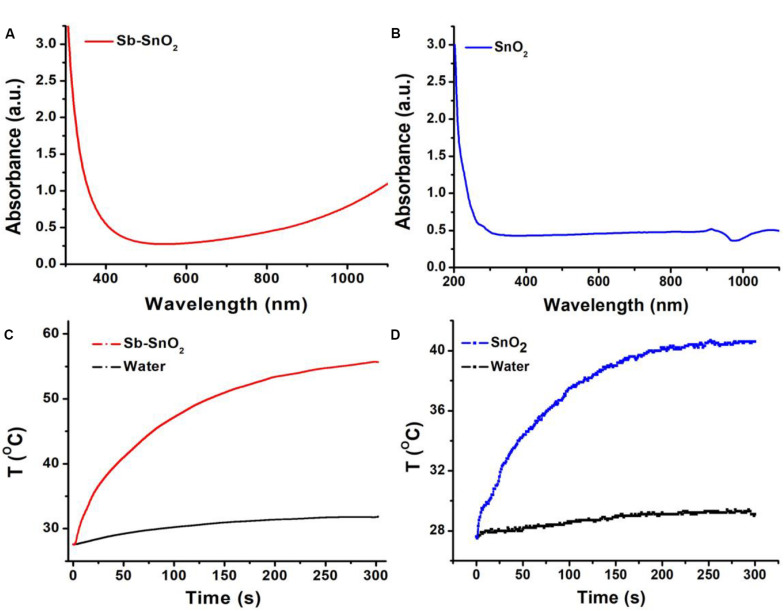
(A) UV-vis spectra and (B) photothermal effect of Sb-SnO2 nanocrystals. (C) UV-vis spectra and (D) photothermal effect of SnO2 nanocrystals.